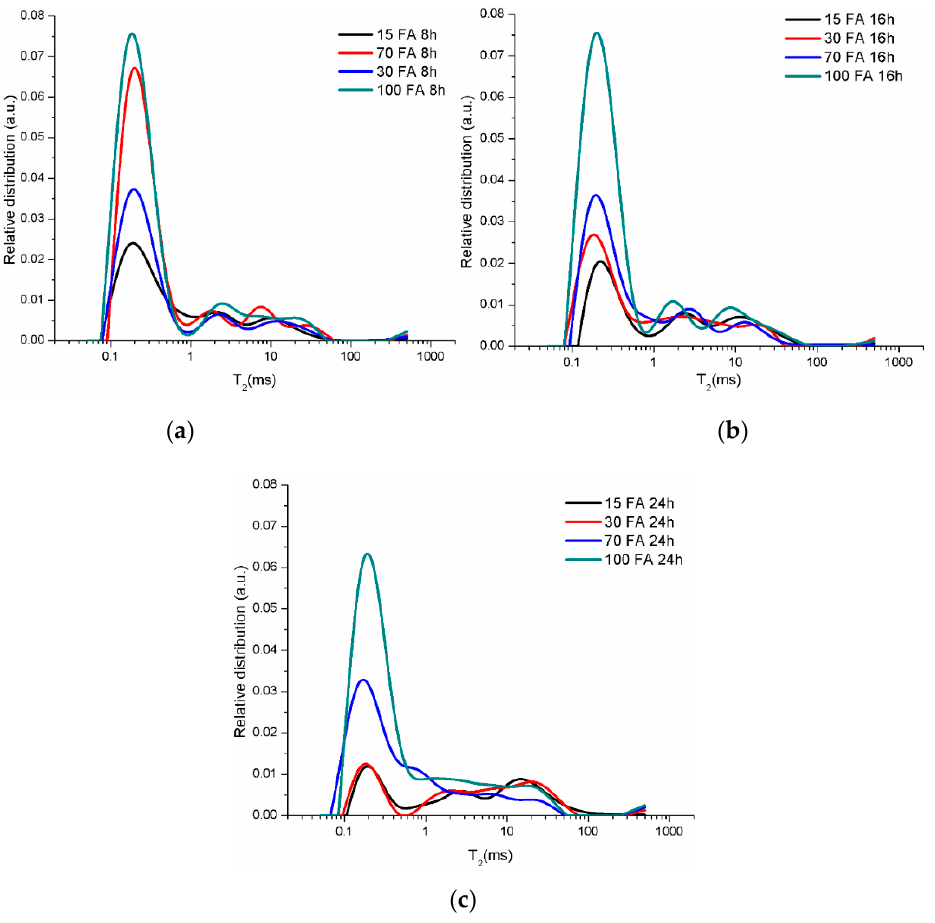
Figure 10. Relative pore size distribution of obtained geopolymers by drying time: ( a ) 8 h; ( b ) 16 h; and ( c ) 24 h. Table 3. Peaks areas and positions on the T 2